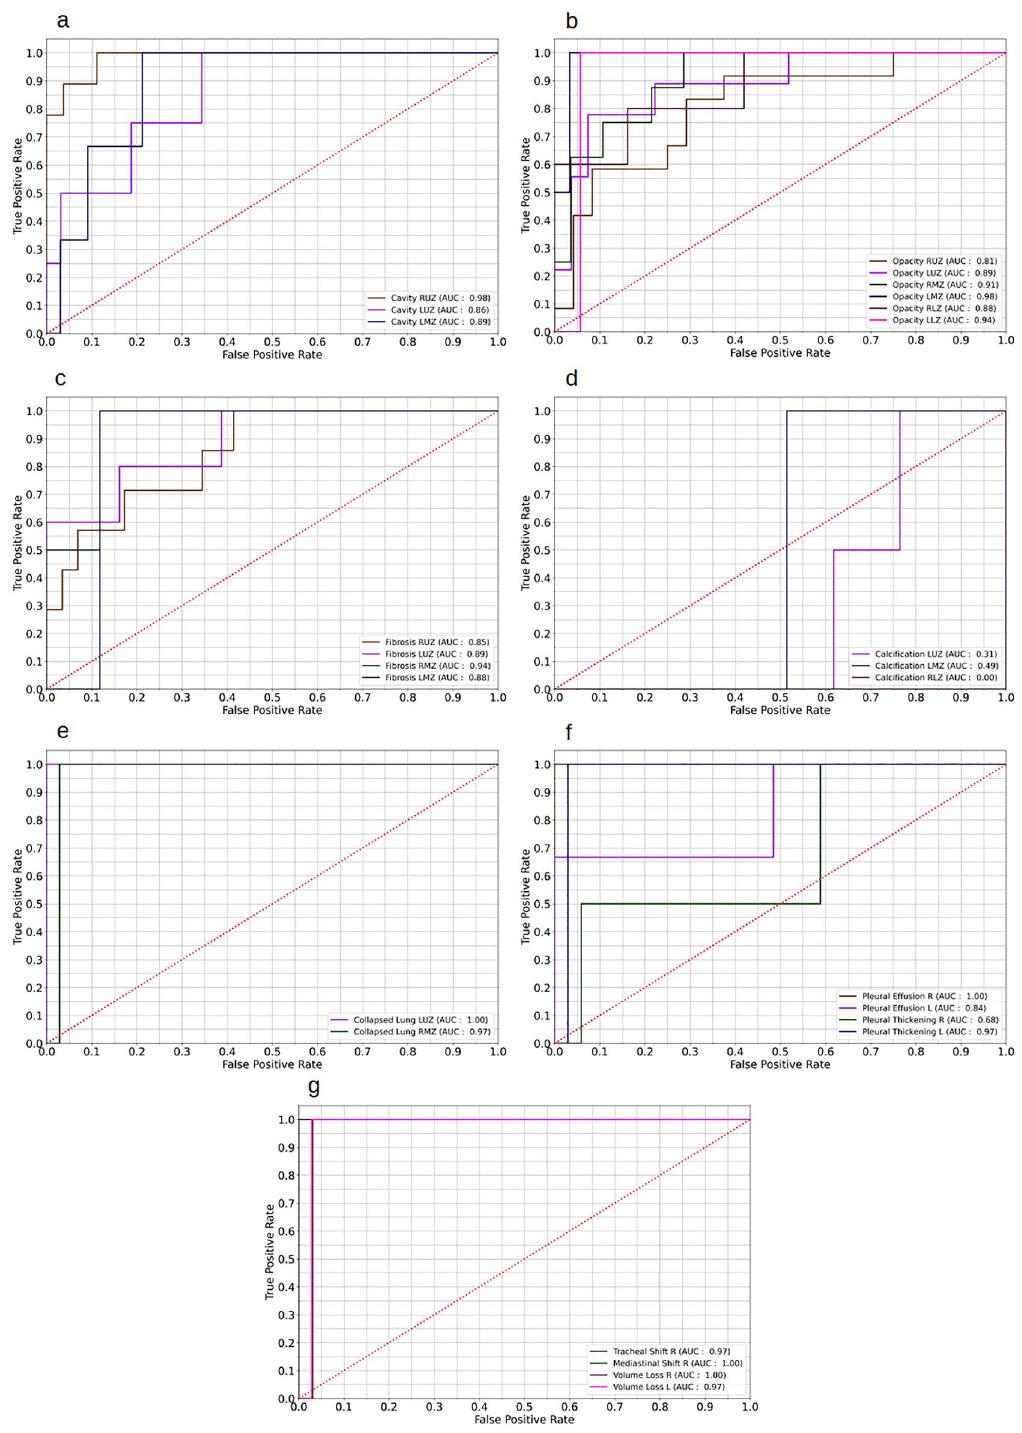
Figure 3. Receiver operating characteristic of lung zone wise abnormalities in external test set. ( a ) Area under receiver operating characteristic (AUC) of cavity. ( b ) AUC of opacity. ( c ) AUC of fibrosis. ( d ) AUC of calcification. ( e ) AUC of collapsed lung. ( f ) AUC of pleural effusion, pleural thickening. ( g ) AUC of tracheal shift, mediastinal shift, volume loss. RUZ right upper zone, RMZ right mid zone, RLZ right lower zone, LUZ left upper zone, LMZ left mid zone, LLZ left lower zone, R right lung, L left